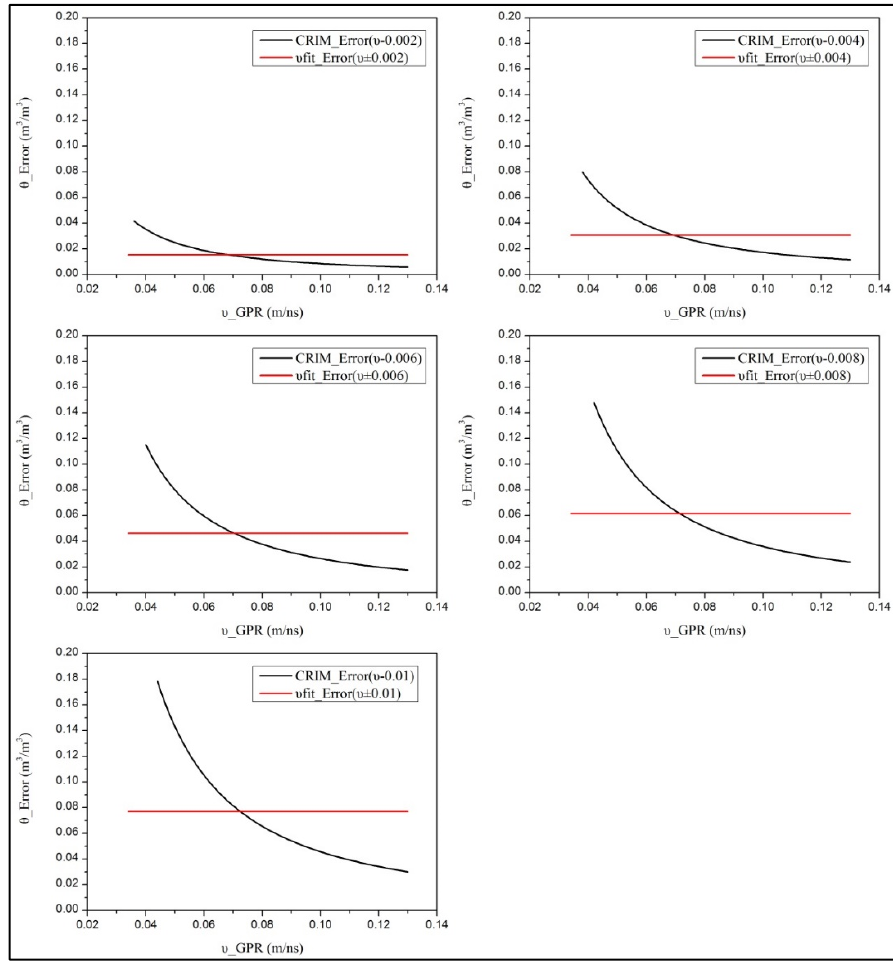
Figure 9. Calculated θ error with variation in GPR velocity (black line: calculated θ error with CRIM, red line: calculated θ error with direct GPR velocity fitting equation).